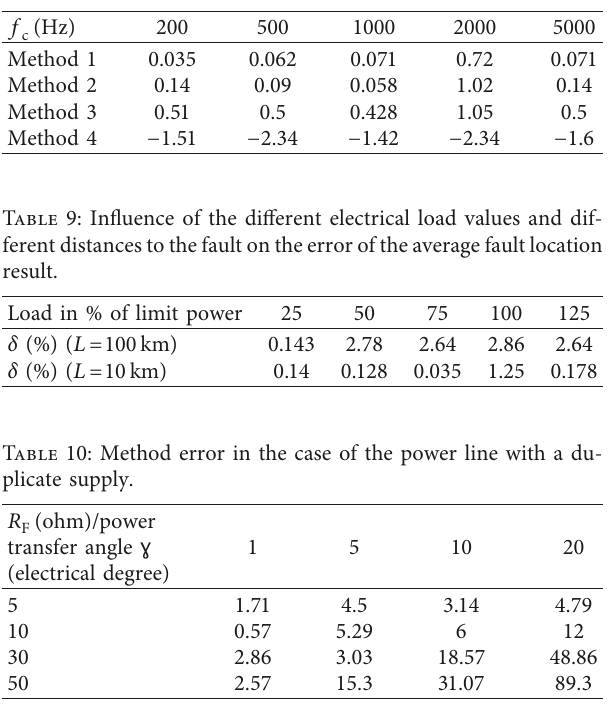
Table 8: Influence of the cutoff filter frequency on the error of average fault location result, l